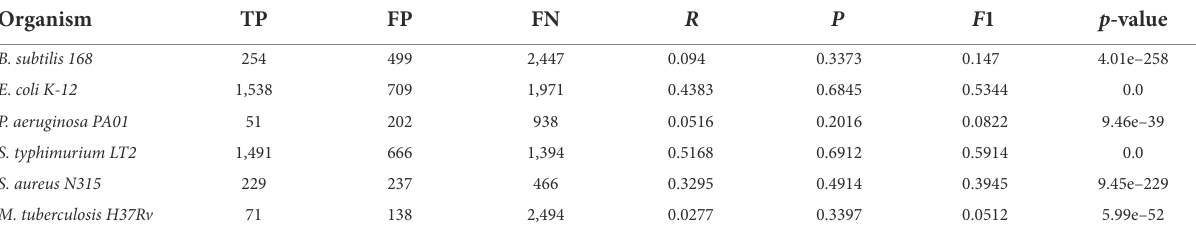
TABLE 2 Single edge comparisons between the six reference networks employed in this work and their counterparts generated following our homology-based transfer approach from the other remaining networks.